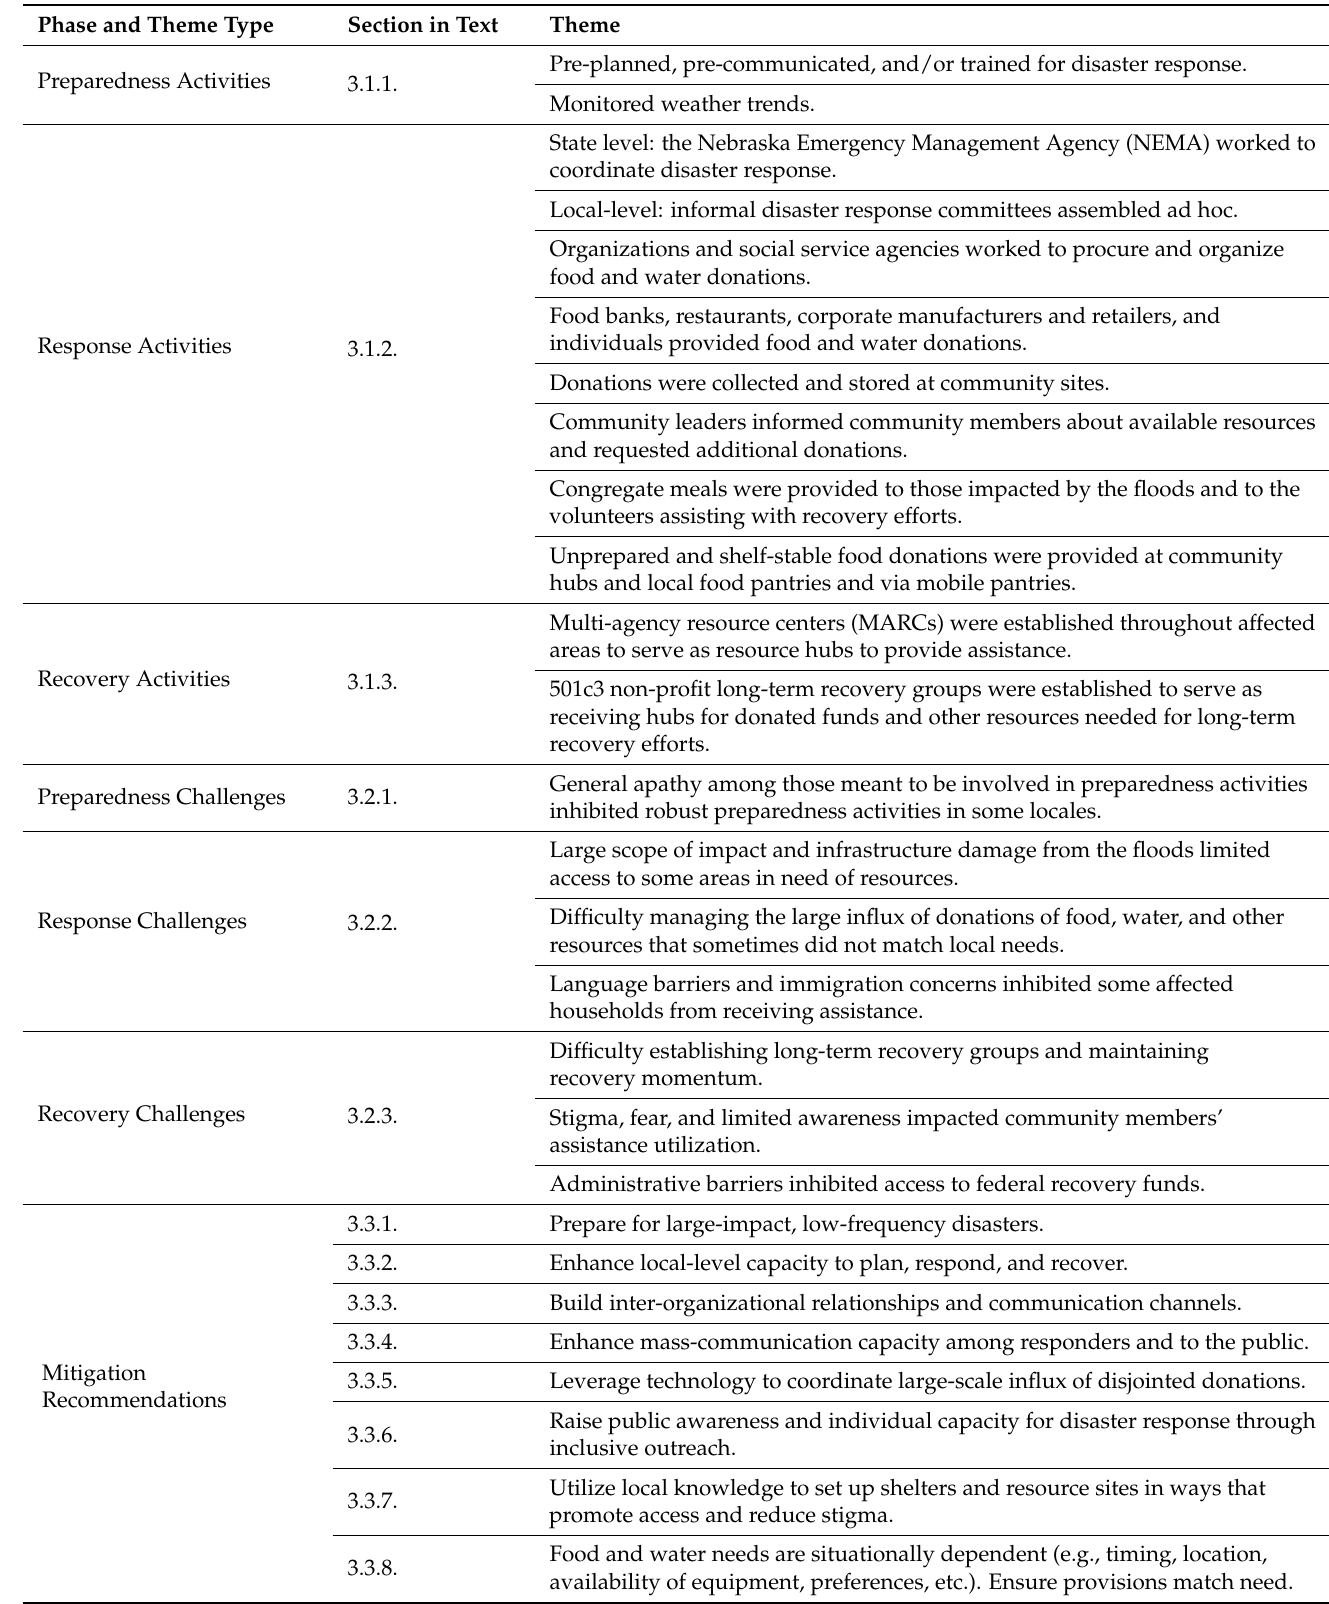
Table 3. Emergent themes related to activities, challenges, and/or recommendations from each phase of the emergency management